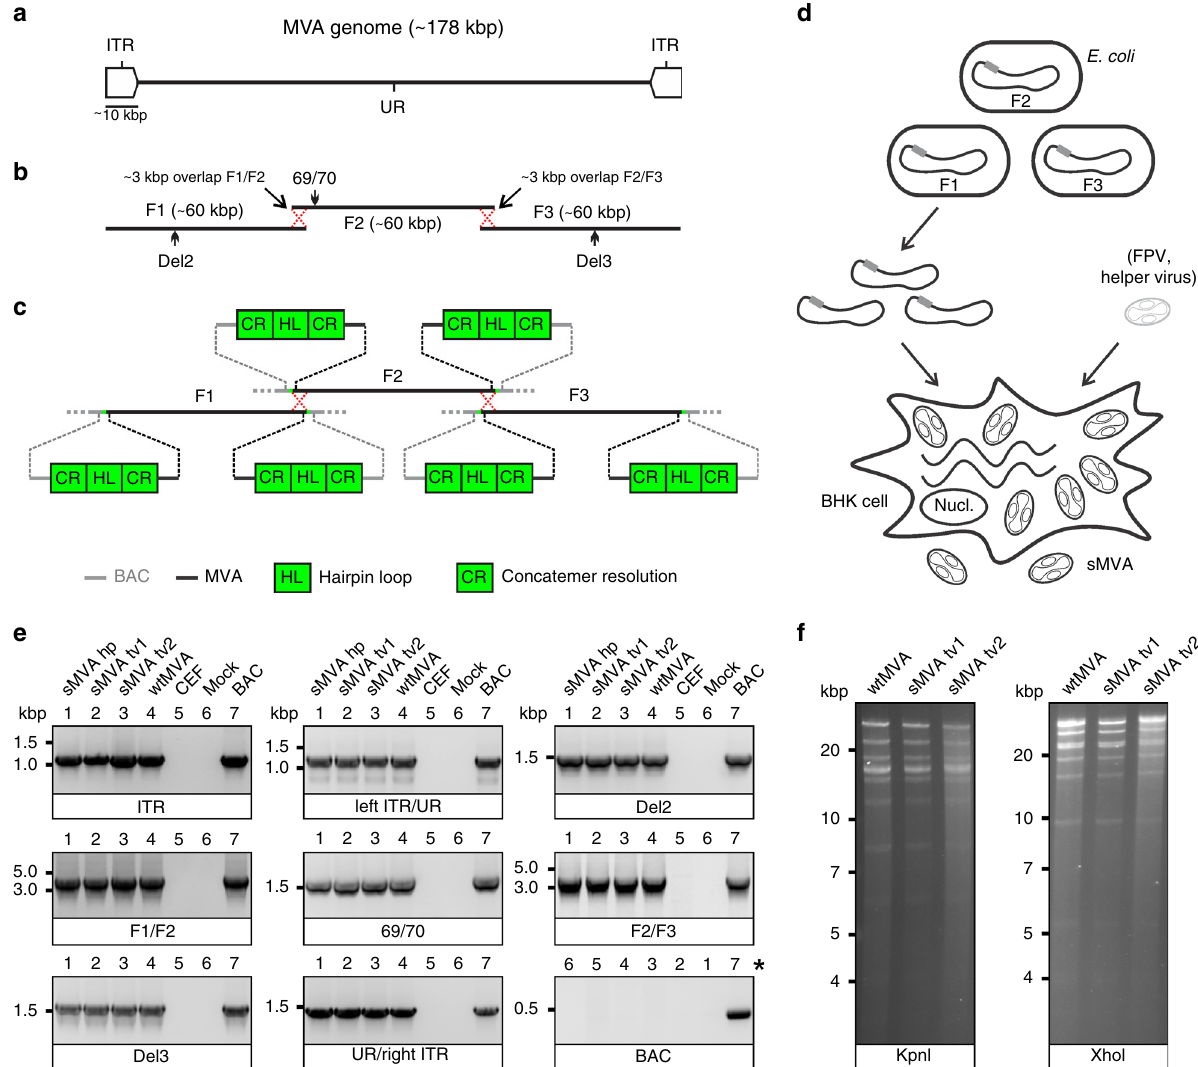
Fig. 1 sMVA construction and characterization. a Schematic of MVA genome. The MVA genome is ~178 kbp in length and contains an internal unique region (UR) fl anked by ~9.6 kbp inverted terminal repeat (ITR) sequences. b sMVA fragments. The three sub-genomic sMVA fragments (F1 – F3) comprise ~60 kbp of the left, central, and right part of the MVA genome as indicated. sMVA F1/F2 and F2/F3 share ~3 kbp overlapping homologous sequences for recombination (red dotted crossed lines). Approximate genome positions of commonly used MVA insertion sites (Del2, IGR69/70, Del3) are indicated. c Terminal CR/HL/CR sequences. Each of the sMVA fragments contains at both ends a sequence composition comprising a duplex copy of the MVA terminal hairpin loop (HL) fl anked by concatemeric resolution (CR) sequences. BAC bacterial arti fi cial chromosome vector. d sMVA reconstitution. The sMVA fragments are maintained in E. coli , isolated from the bacteria, and co-transfected into BHK cells, which are subsequently infected with FPV as a helper virus to initiate sMVA virus reconstitution. e PCR analysis. CEFs infected with sMVA, derived with either FPV HP1.441 (sMVA hp) or with FPV TROVAC from two independent virus reconstitutions (sMVA tv1 and sMVA tv2), were investigated by PCR for several genome positions, including the ITR sequences, the transition from the left or right ITR into the internal UR (left ITR/UR; UR/right ITR), the Del2, IGR69/70 and Del3 insertion sites, and the F1/F2 and F2/F3 recombination sites. The removal of the BAC vector sequences was also investigated. PCR with wtMVA-infected and uninfected cells, without sample (mock), or with MVA BAC was performed as controls. *Note the different sample order for the BAC-speci fi c PCR as indicated by numbers. f Restriction pattern analysis. Viral DNA isolated from ultra-puri fi ed sMVA (sMVA tv1 and sMVA tv2) or wtMVA virus was compared by KpnI and XhoI restriction enzyme digestion. Experiments in e and f were performed twice with similar